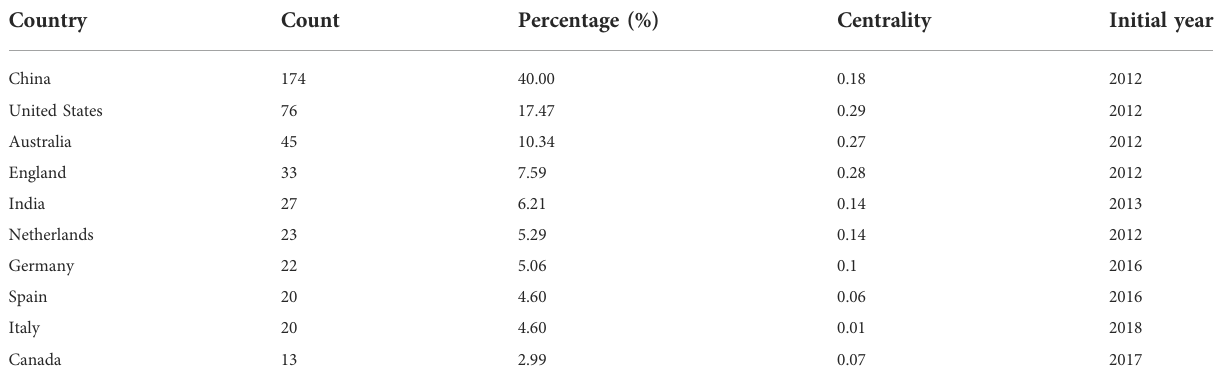
TABLE 1 Top ten most productive countries in terms of relevant articles. Country